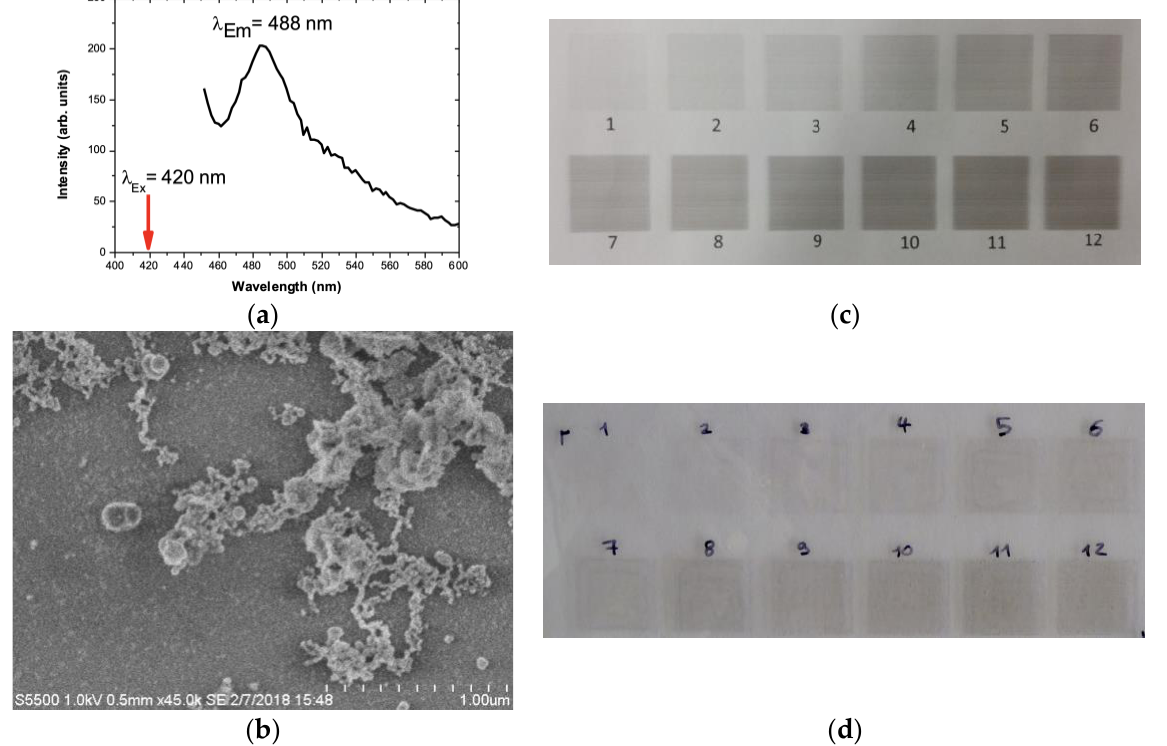
Figure 8. ( a ) Photoluminescence analysis of AgNPs produced recirculatory-flow LASiS showing the appearance of a fluorescence peak at 488 nm (excitation wavelength 420 nm). ( b ) FE-SEM analysis of silver nano-ink-coated cyclo olefin, AgNPs ink (18% isopropanol, 82% AgNPs containing deionised water) overprint trials on polymer ( c ) cellulose and ( d ) plasma cleaned cyclo-olefin polymer sheets (COP). The numbers indicate the number of overprints on the same square print area.